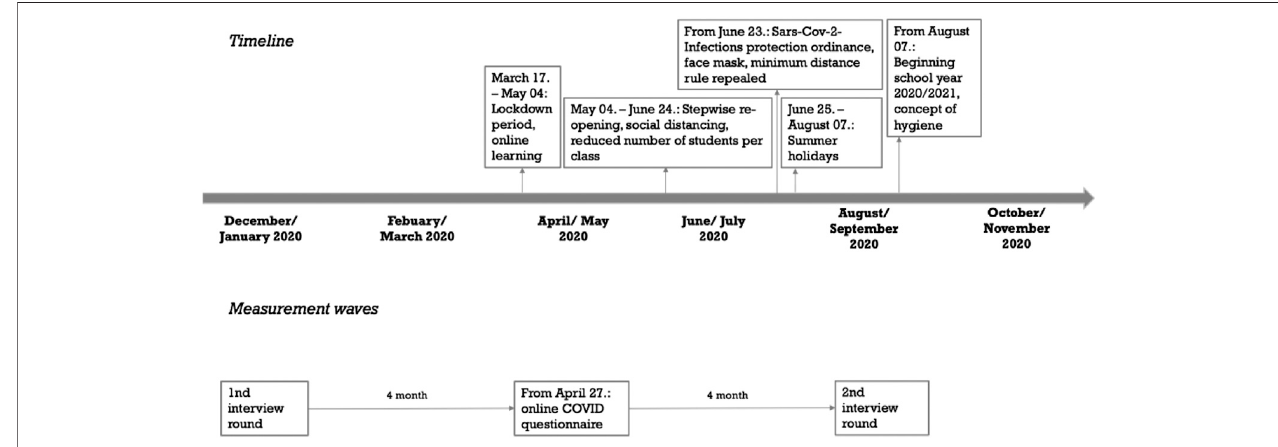
FIGURE1| Thechronology ofdatacollection,trainingprocess,and measurement wavesalongwiththeCOVID-19 – speci fi